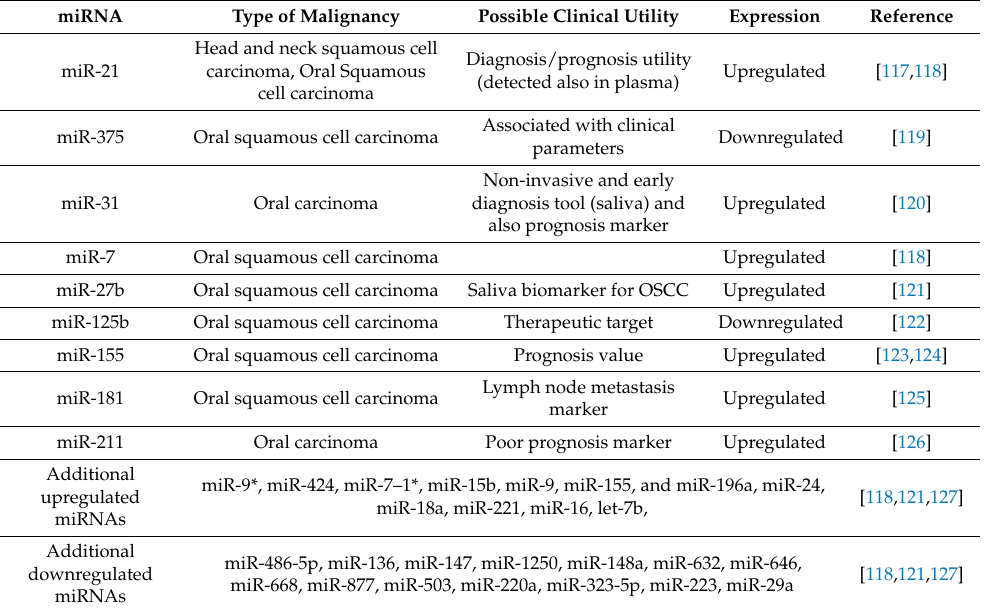
Table 2. Most significant dysregulated miRNAs in oral